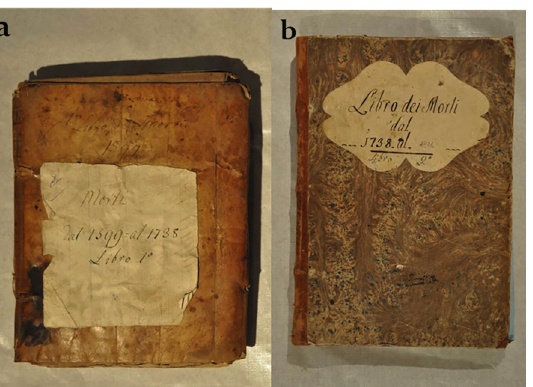
Fig 10. Two ancient parish records: the first from 1599 to 1738 (a), the second one from 1739 to 1891 (b).